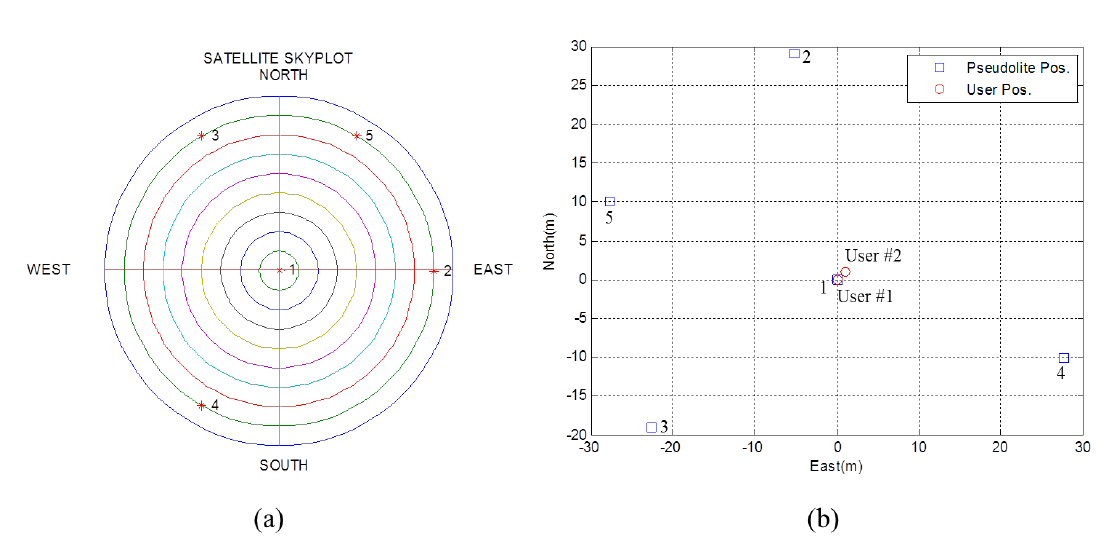
( b ) Local positions of pseudolites and user.